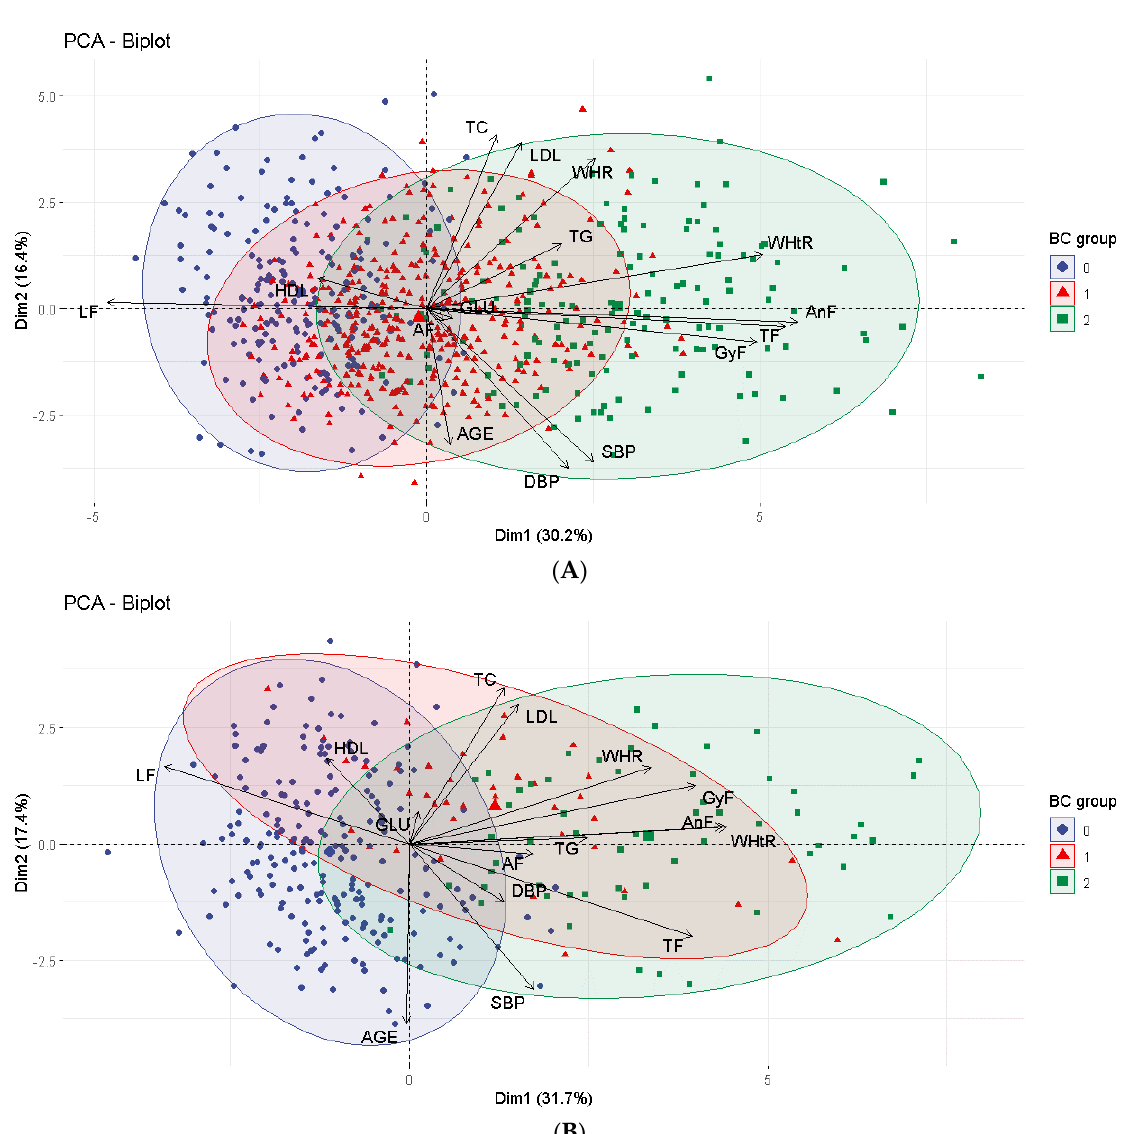
Figure 1. Cardiometabolic risk factors associated with each body composition group, for females ( A ) and males ( B ). Legend: 0 — eutrophy by BMI and adequate %BF (CG1); 1 — eutrophy by BMI and high %BF (SG); 2 — excess weight by BMI and high %BF (CG2). AF: arm fat; AnF: android fat; BC: body composition; BMI: body mass index; DBP: diastolic blood pressure; GyF: gynoid fat; GLU: glucose; HDL: high-density lipoprotein; LF: leg fat; LDL: low-density lipoprotein; SBP: systolic blood pressure; TC: total cholesterol; TF: trunk fat; TG: triglycerides; WHtR: waist – height ratio; WHR: waist – hip ratio.